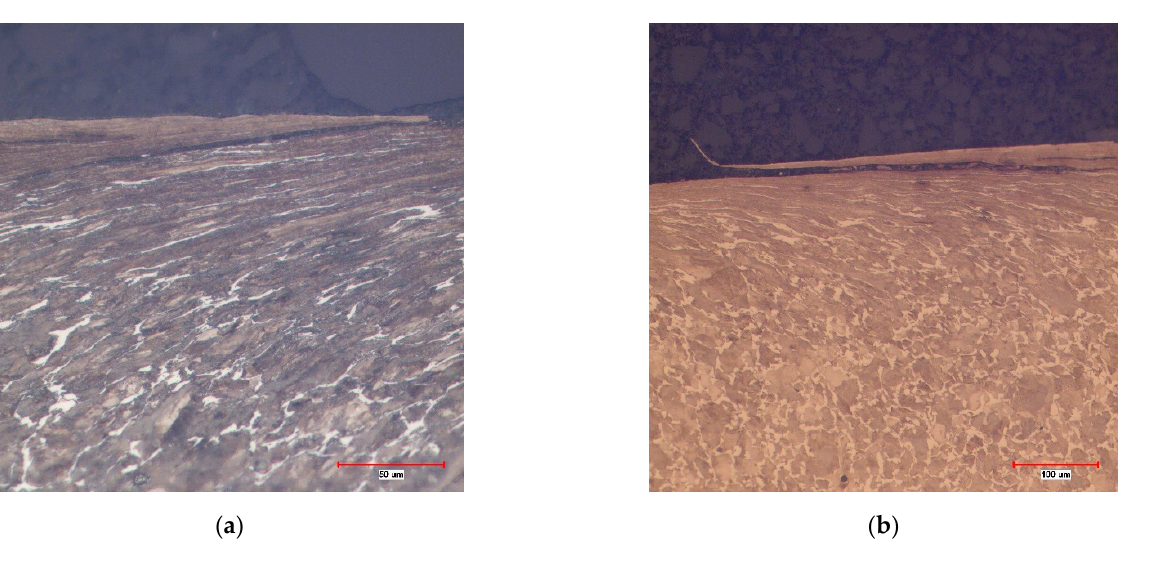
Figure 21. Microstructure and cracks generated on the surfaces of wheel and rail specimens: ( a ) wheel specimen (R7); ( b ) Rail specimen (UIC60).